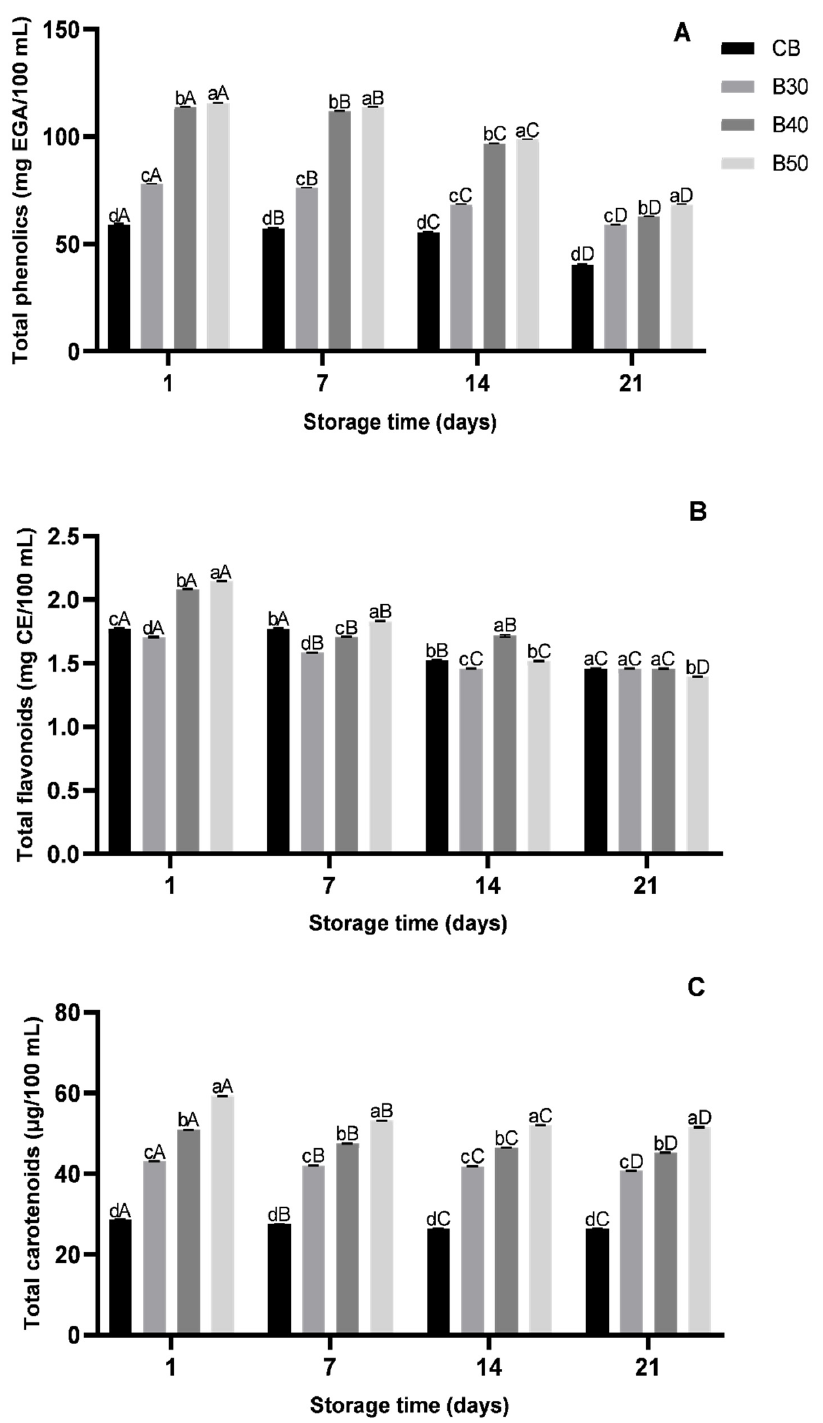
Figure 1. Contents of bioactive compounds in formulated beverages during 21 days of refrigeration storage (4 °C). ( A ) Total phenolic compounds, ( B ) total flavonoid and ( C ) total carotenoid contents in four formulated beverages. Error bars represent the standard deviation of the mean ( n = 3). Different lowercase letters on the same storage time differ ( p < 0.05) among beverage formulations, and different uppercase letters for the same beverage formulation differ ( p < 0.05) among different storage time periods based on Tukey’s test. CB—control beverage; B30—beverage with 30% of xique-xique cladode juice; B40—beverage with 40% of xique-xique cladode juice; B50—beverage with 50% of xique-xique cladode